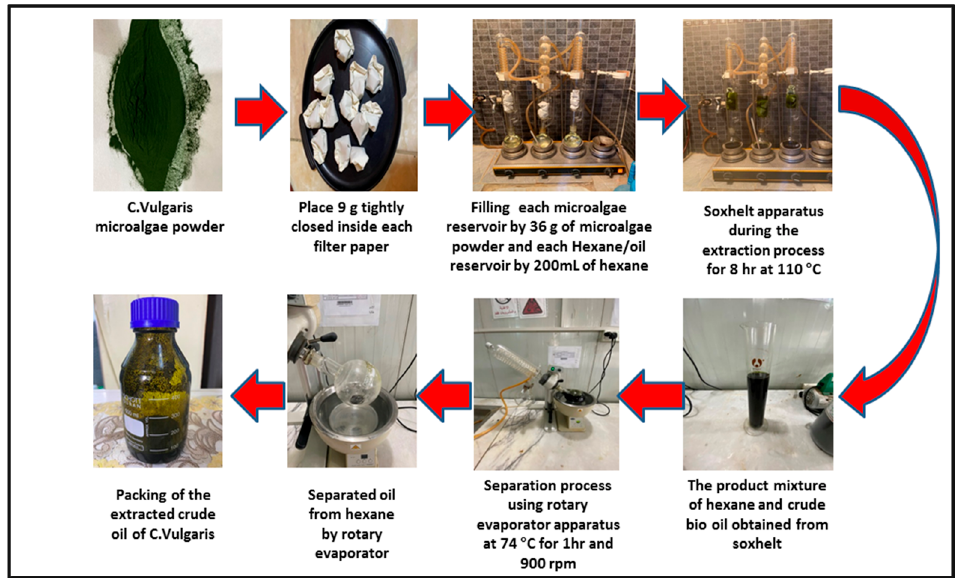
Figure 1. Experimental images for the procedure of extraction of the crude oil from Chlorella Vulgaris microalgae powder.